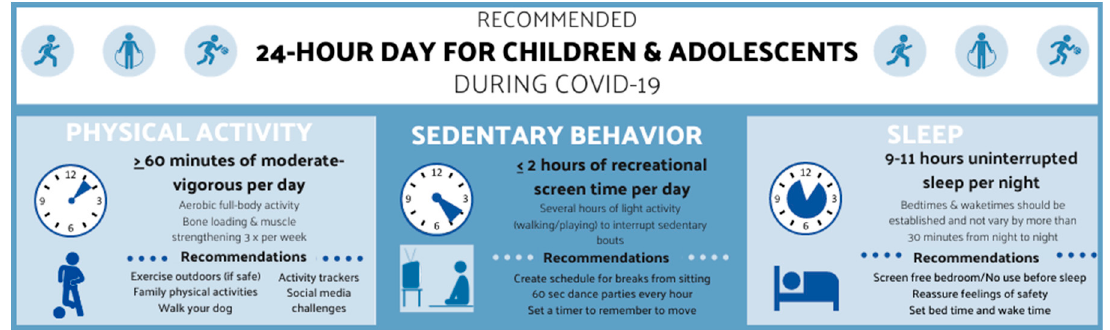
Figure 3. The 24-h movement behavior recommendations during the COVID-19 pandemic.